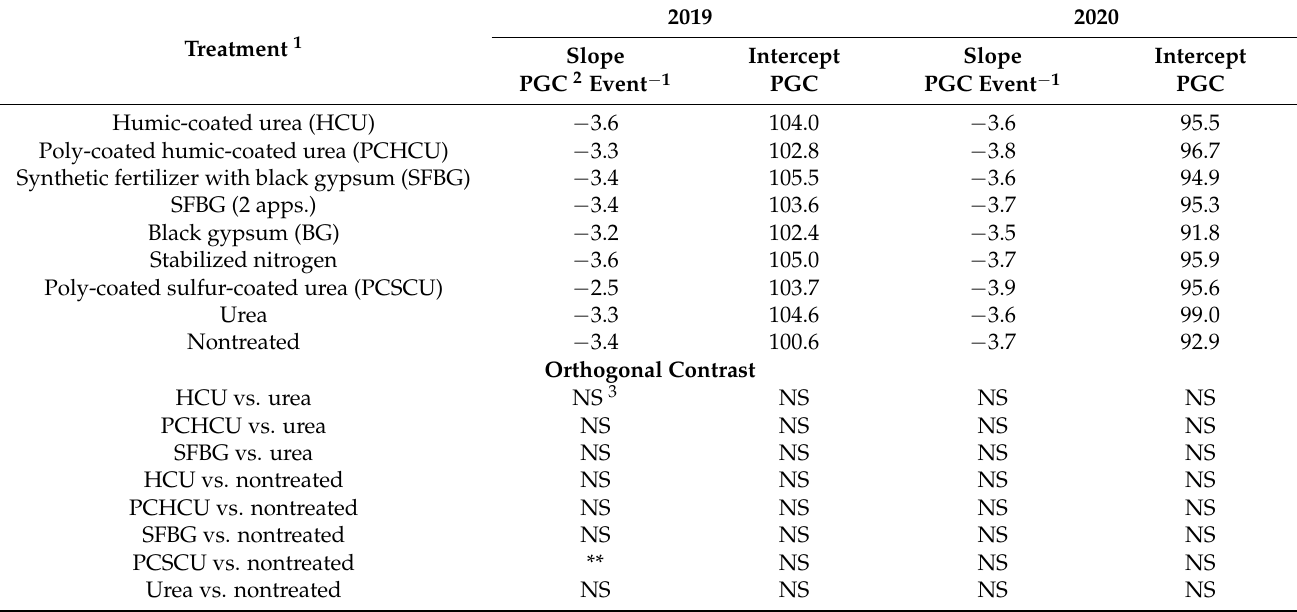
Table 2. Effects of various fertilizers on percent green cover (PGC) of a Kentucky bluegrass ( Poa pratensis L.) subjected to simulated traffic using a modified Baldree traffic simulator with three traffic events week − 1 (25 traffic events total) in fall of 2019 and 2020 in Ames, IA,